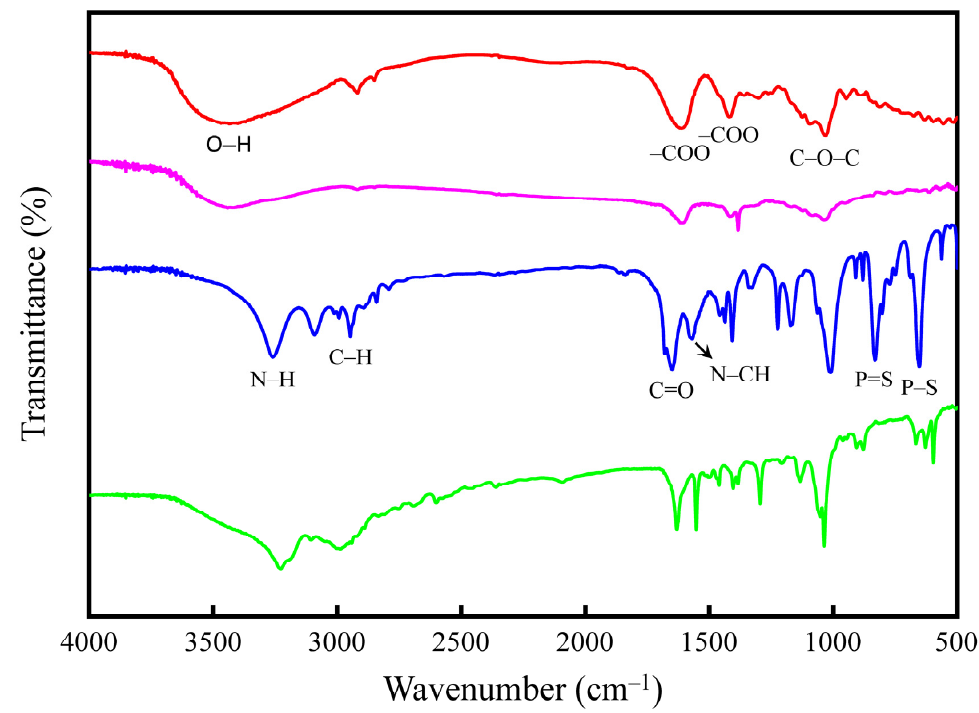
Figure 3. FT-IR spectra of SA (red line), SA-AgNPs (purple line), dimethoate (blue line), and SA-AgNPs with dimethoate (green line).